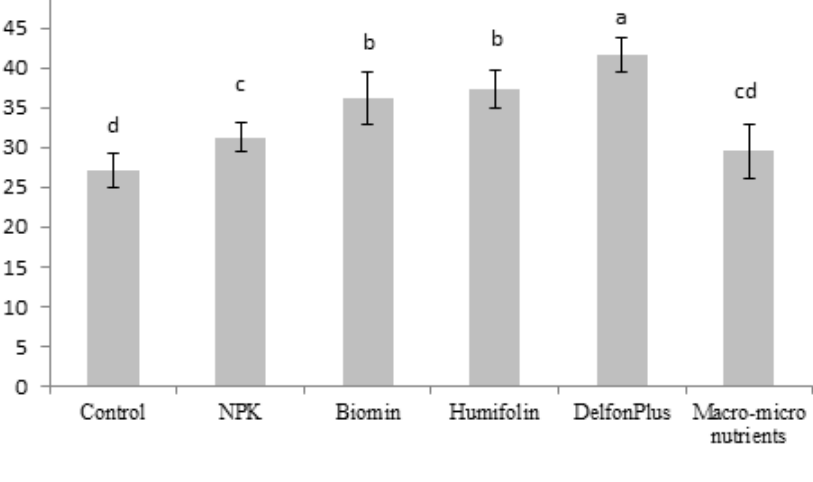
Figure 2: Mean values of pod vitamin C of green bean plants treated with foliar applications of different organic chelates, a mix of nutrients and soil applied NPK under greenhouse conditions. Bars indicate standard deviations. Different letters across all foliar treatments are statis- tically different (P=0.05)